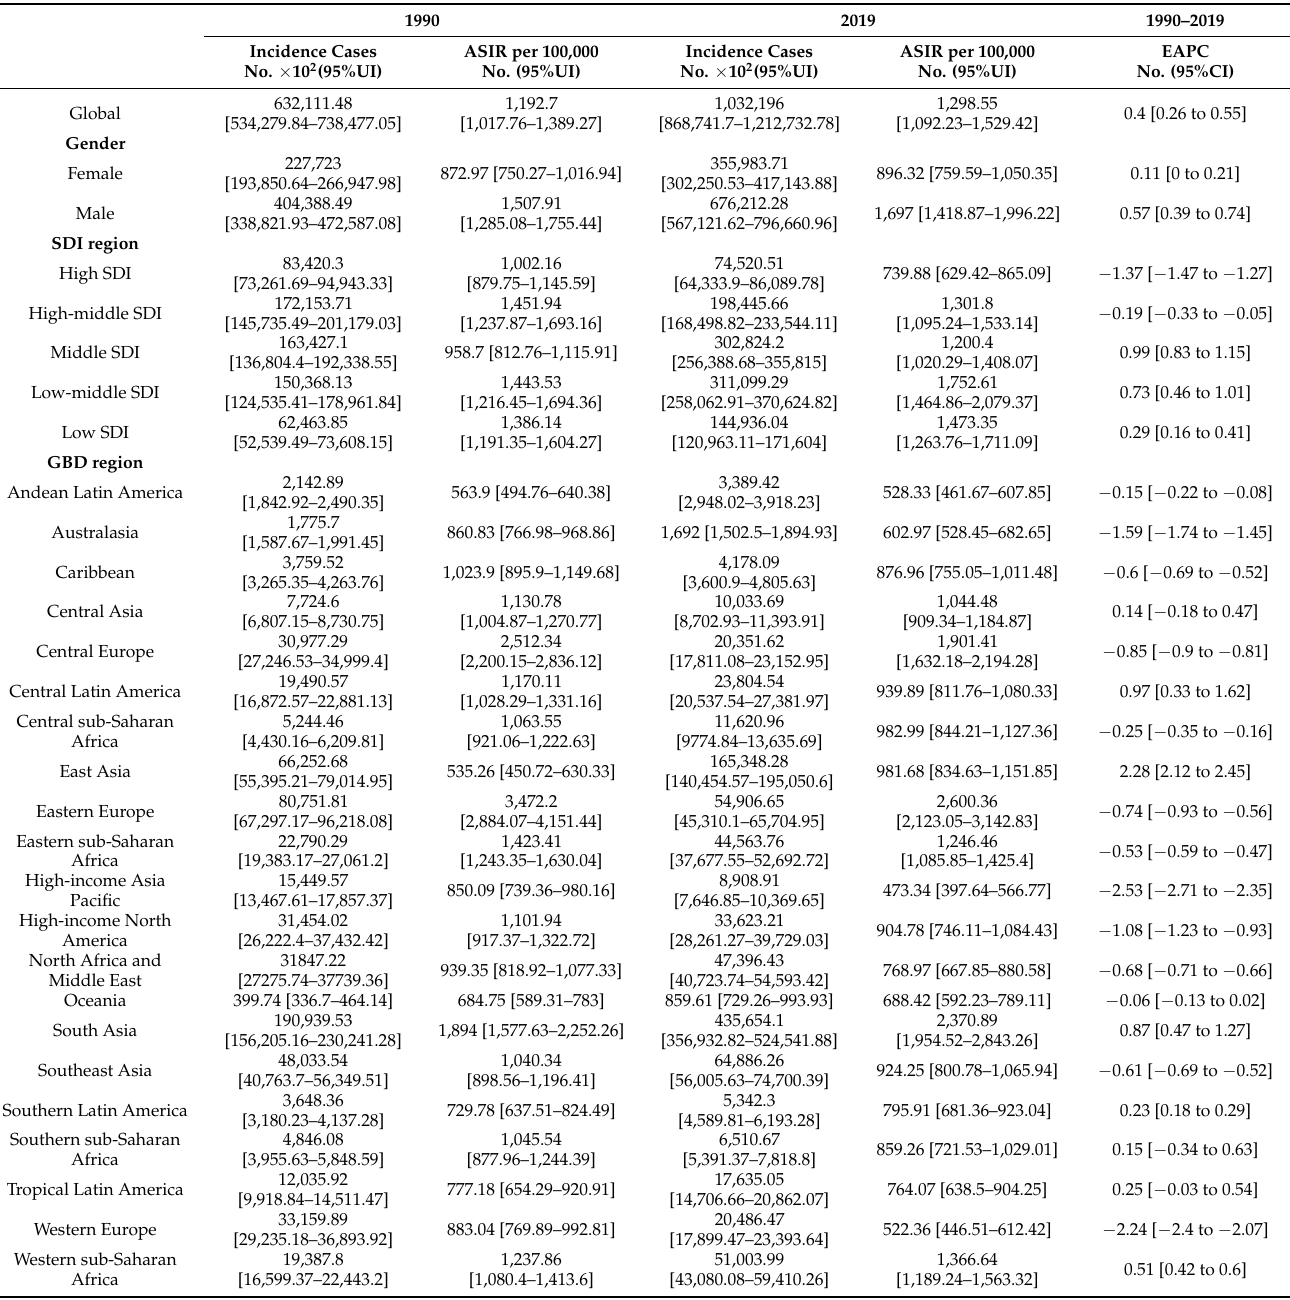
Table 1. Incidence case, ASIR, and temporal trends of RIs in 1990 and